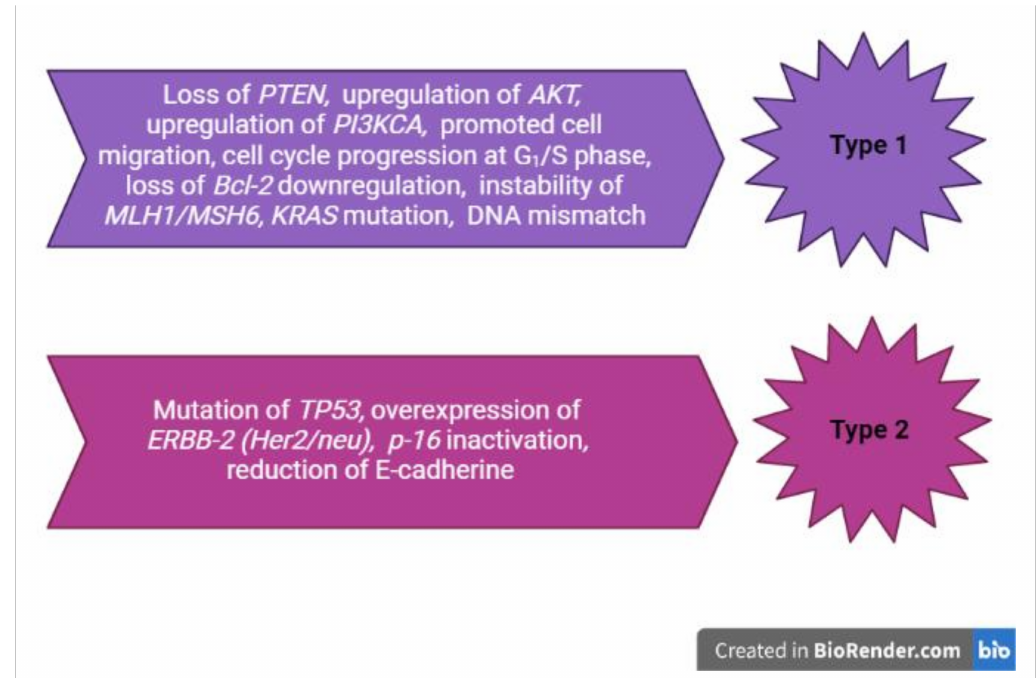
Figure 1. Molecular mechanisms of endometrial cancer